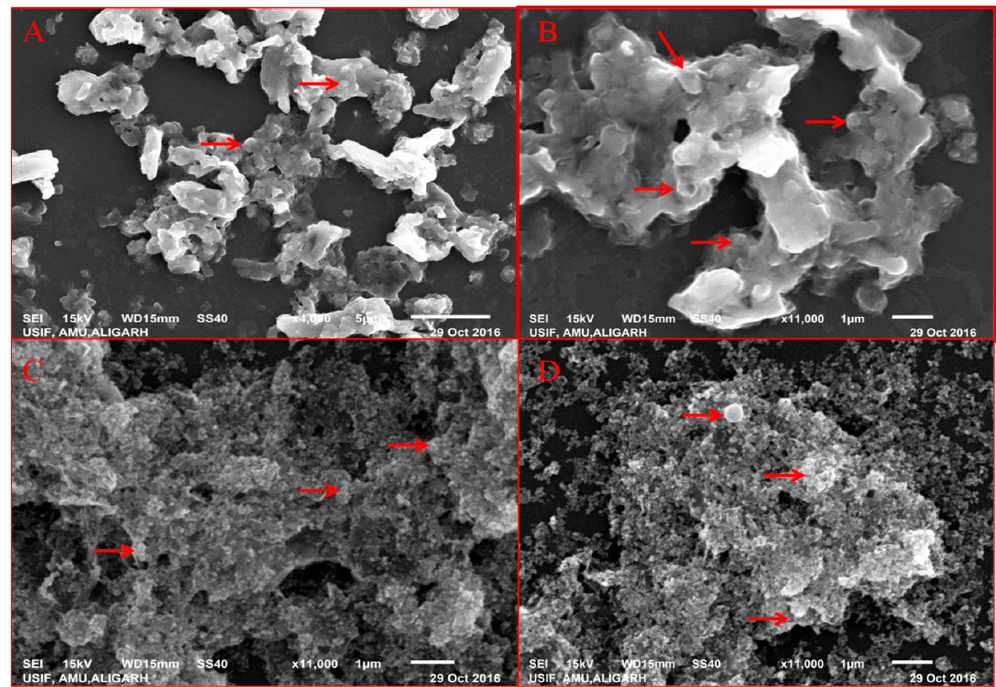
Figure 3. SEM of BM-ZnO NPs at different concentration of extract. ( A ) 10 mL, ( B ) 20 mL, ( C ) 30 mL, ( D ) 40 mL of extract.